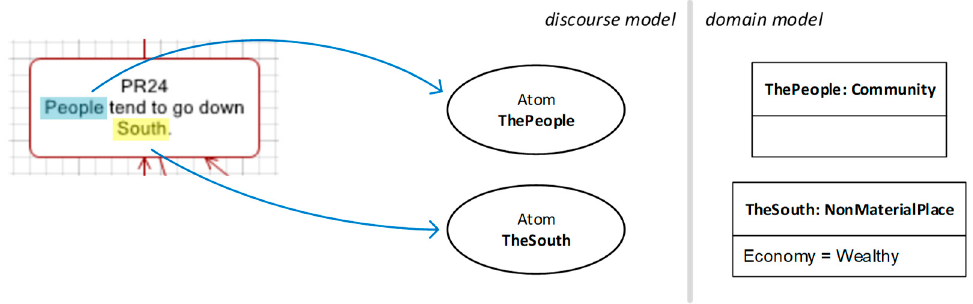
Figure 8. This depicts the same situation that was shown in Figure 6, but using the IAT+ notation introduced earlier plus some additional lines and symbols. Ellipses represent ontological proxies, that is, instances of OntologyElement in Figure 7. Matching elements in the domain model are shown to the